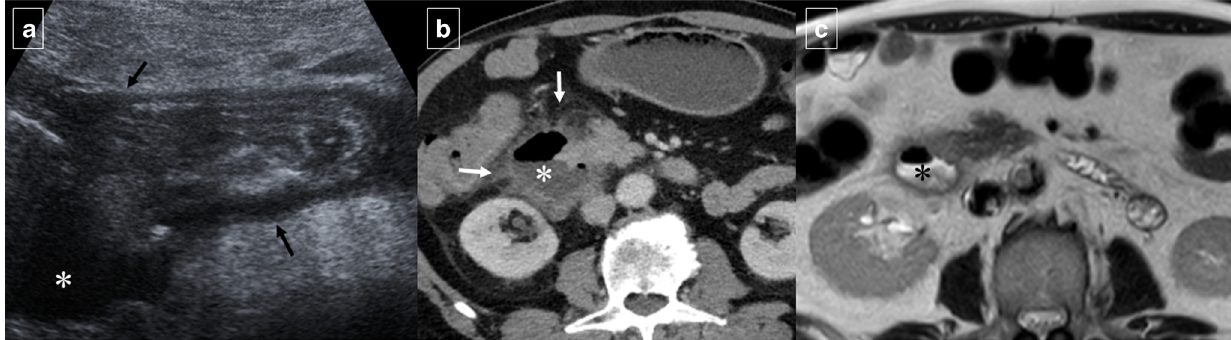
Fig. 4 A 67-year-old man with epigastralgia, fever, and food intolerance. a Initial abdominal ultrasonography shows diffuse thickening of the different layers of the duodenal wall with a slight amount of free periduodenal fluid (arrows) and an adjacent hypoechoic fluid collection (*). b Axial contrast-enhanced CT confirms the presence of a paraduodenal collection with an air-fluid level (*) and surrounding soft-